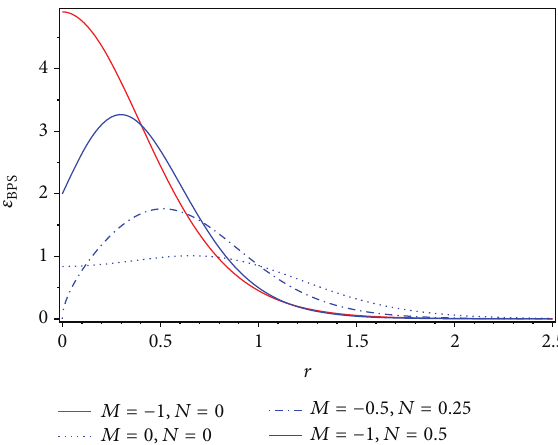
Figure 5: The profiles of the BPS energy density 𝜀 BPS (𝑟) for 𝑛 = 1 . The red lines represent the solutions for a |𝜙| 4 potential and blue lines for |𝜙| 6